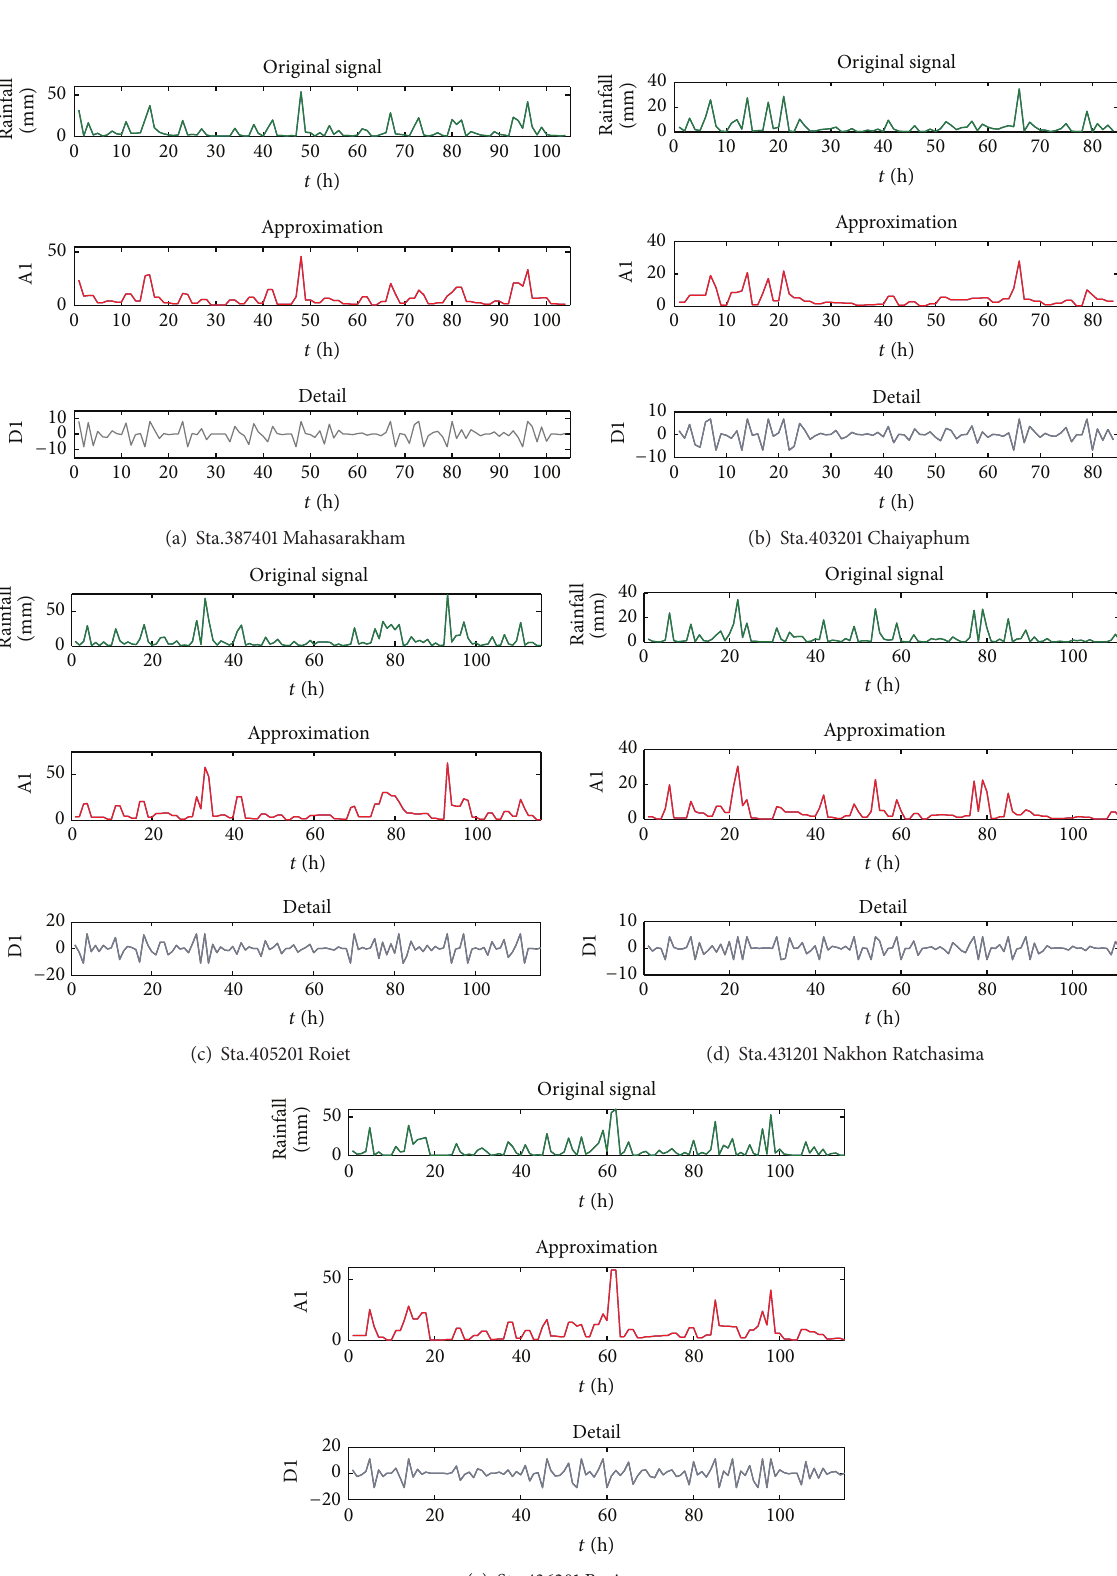
Figure 5: Rainfall data filtration by Haar wavelet filter type for each